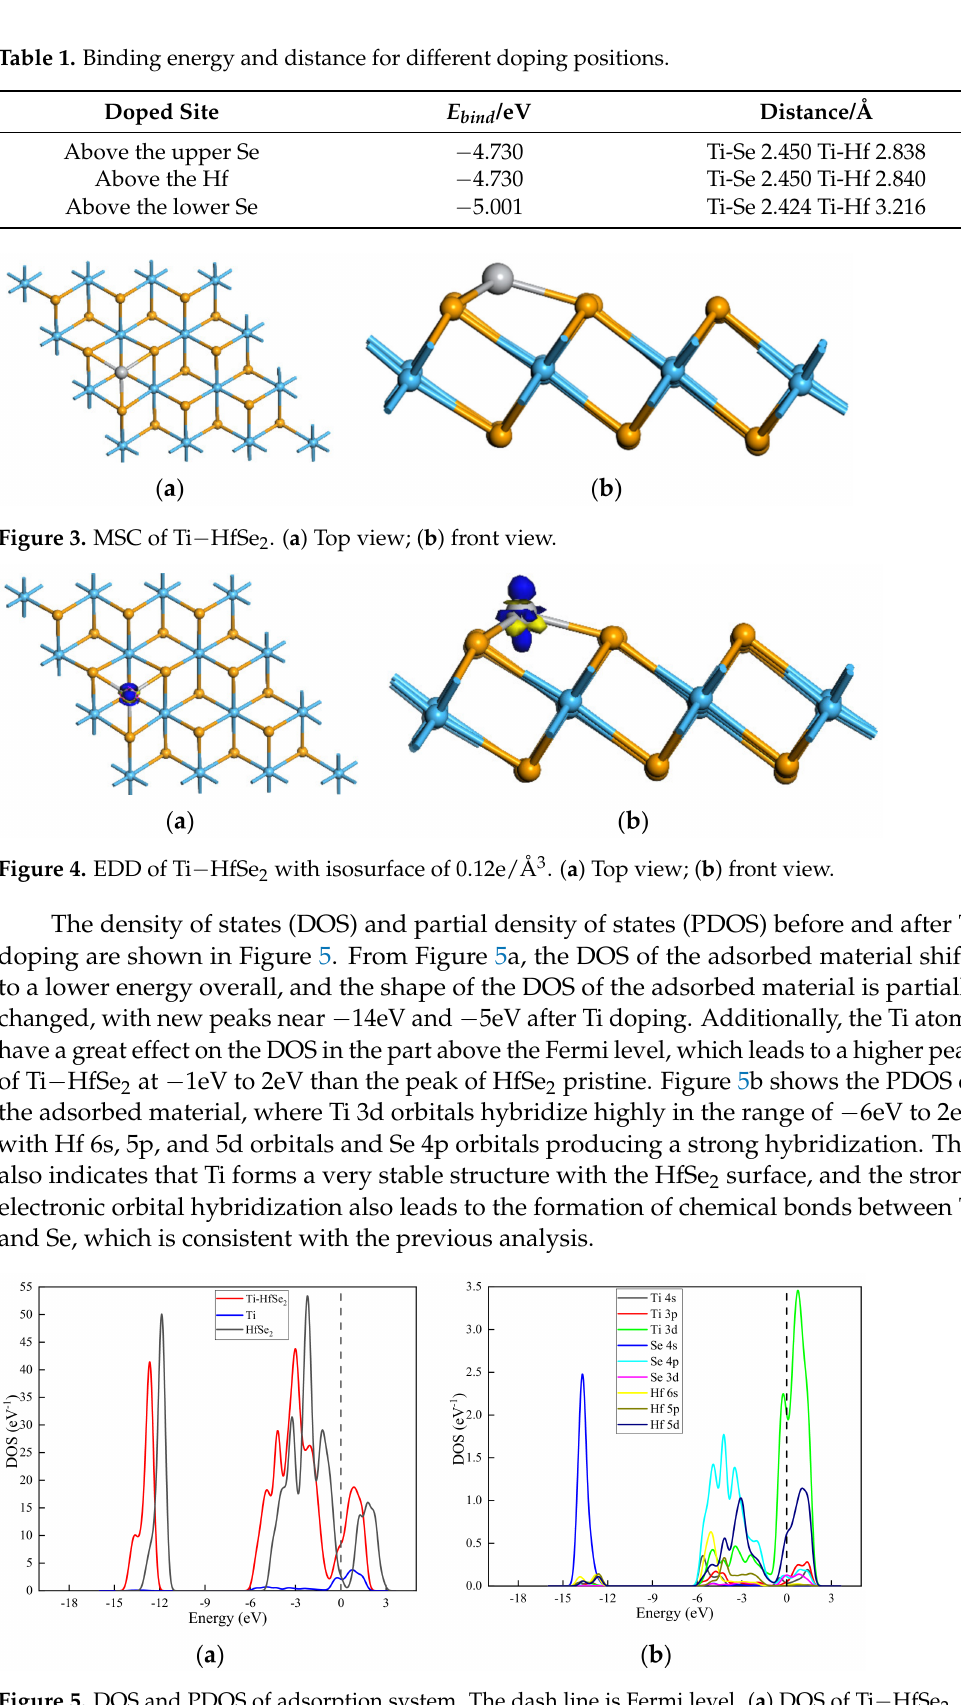
Figure 5. DOS and PDOS of adsorption system. The dash line is Fermi level. ( a ) DOS of Ti − HfSe 2 , Ti and HfSe 2 ; ( b ) PDOS of Ti − HfSe 2